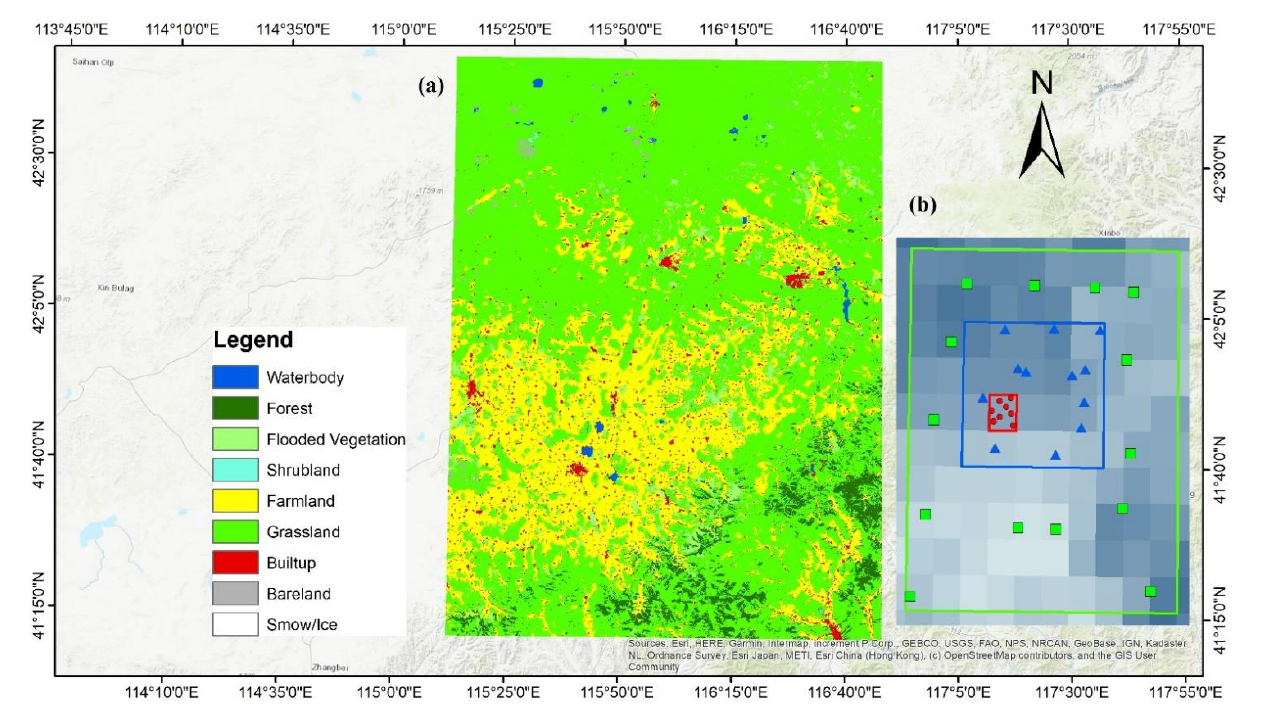
Figure 1. The ShanDian River Basin and the Network within the ShanDian River Basin (SMN-SDR), ( a ) land use map of the study area, ( b ) providing in situ SM measurements at a small scale (red circles within the red rectangles), medium scale (blue triangles within the blue rectangles), and large scale (green squares within the